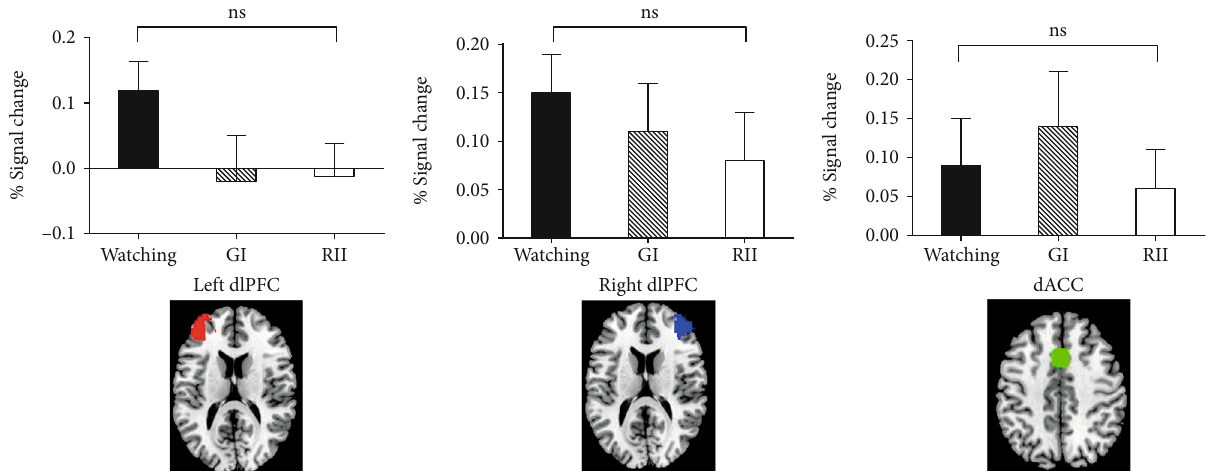
Figure 4: The neural responses of the left and right dlPFC and dACC in the watching, goal intention (GI), and reappraisal by implementation intention (RII) conditions. Errorbars = SEM ; ns stands for not signi fi cant. Table 1: Voxel-wise group activations by 3-by-2 ANOVA with picture type and strategy type as repeated factors. Brain